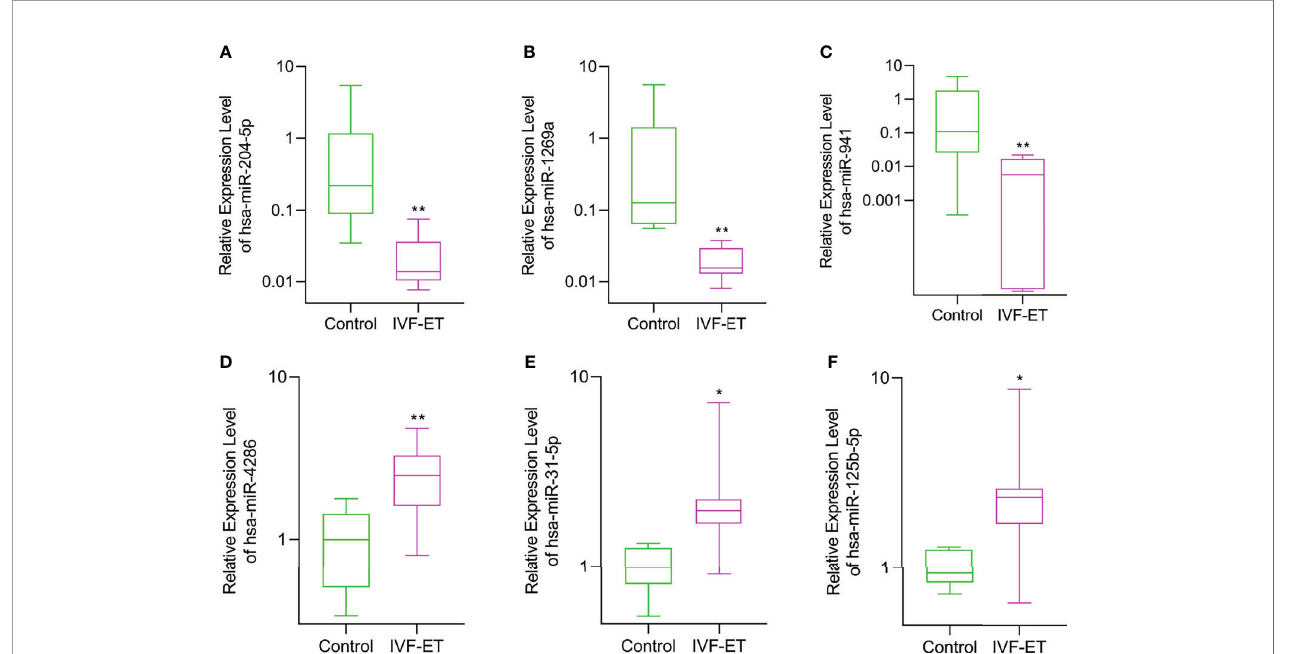
FIGURE 3 | Validation of differential expression of randomly selected DEmiRs in IVF-ET versus control placental tissues. The relative expression levels of (A) hsa- miR-204-5p, (B) hsa-miR-1269a, (C) hsa-miR-941, (D) hsa-miR-4286, (E) hsa-miR-31-5p and (F) hsa-miR-125b-5p were measured in an independent cohort of placental tissues from uncomplicated IVF-ET (n = 8) and natural conceived pregnancies (n = 8). Box and whisker plot with relative expression plotted in log scale showing the range (whiskers), fi rst and third quartiles (boxes) and median values. * P < 0.05, ** P <